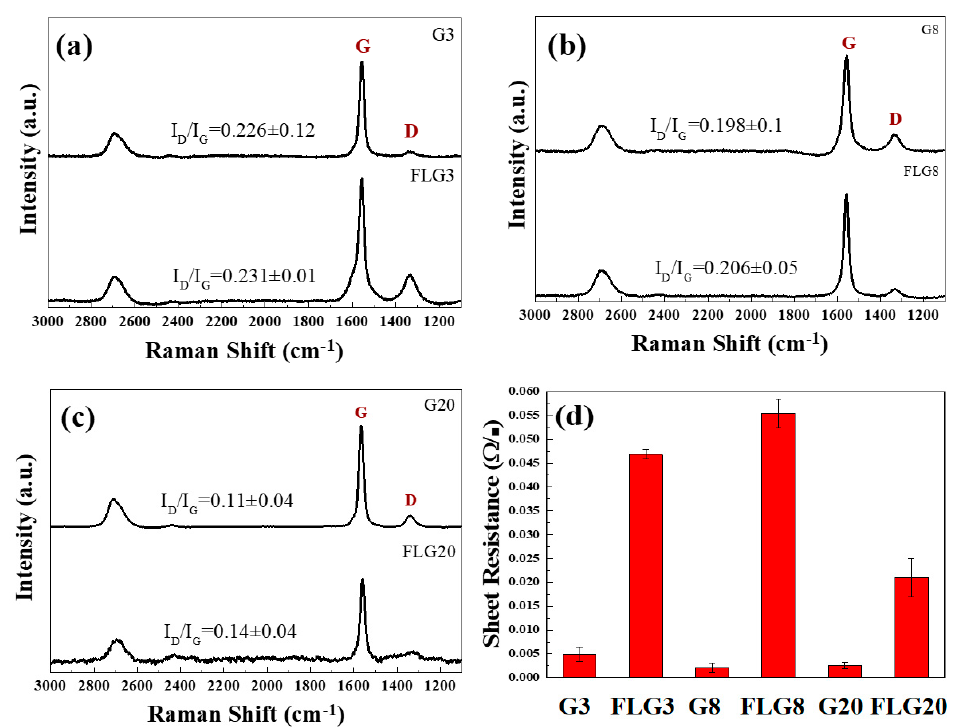
Figure 4. Raman spectra of ( a ) G3 and FLG3, ( b ) G8 and FLG8, and ( c ) G20 and FLG20, and ( d ) the sheet resistance of graphite and FLG.